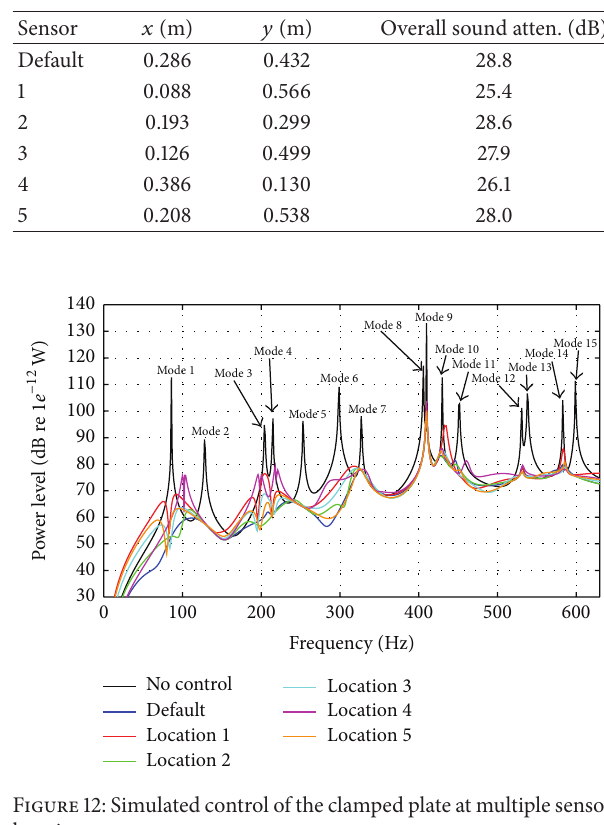
Table 6: The sensor locations used to test the sensitivity of WSSG to sensor placement on the plate of dimensions 0.483 m × 0.762 m.